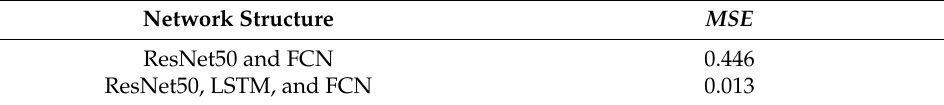
Table 3. Steering wheel angle mean square error loss.